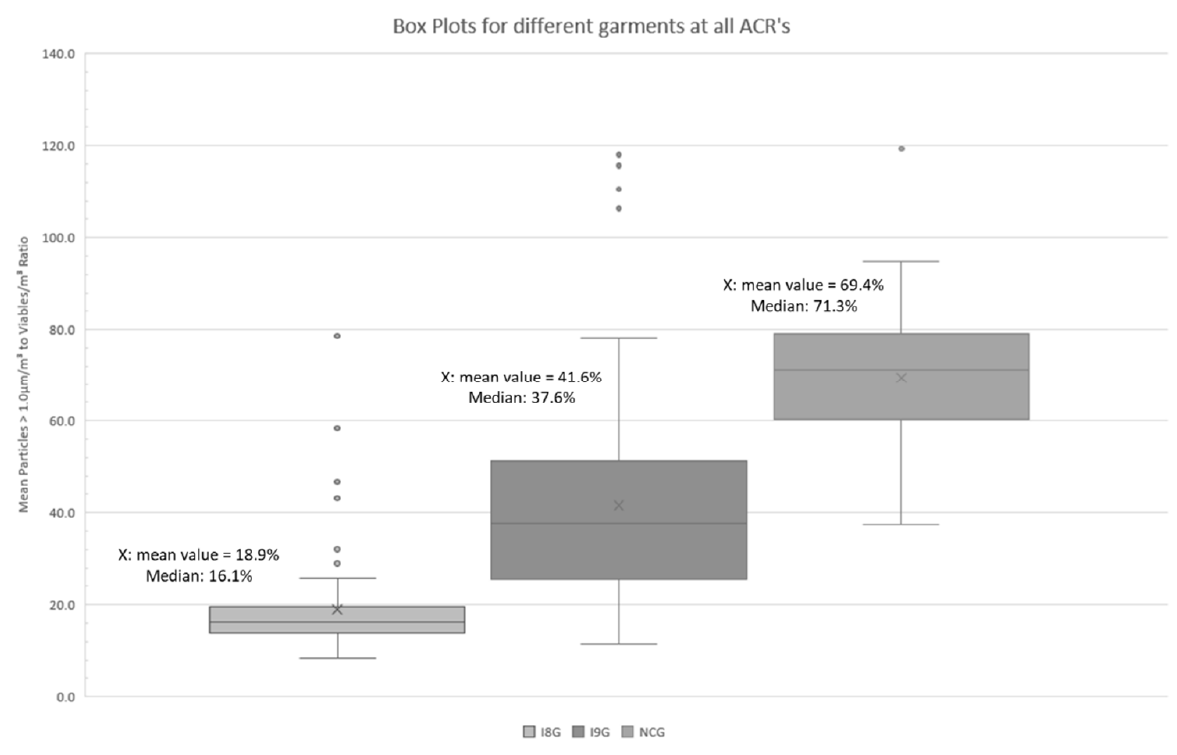
Figure 9. Particle/Viable ratio for different garments at all ACRs.